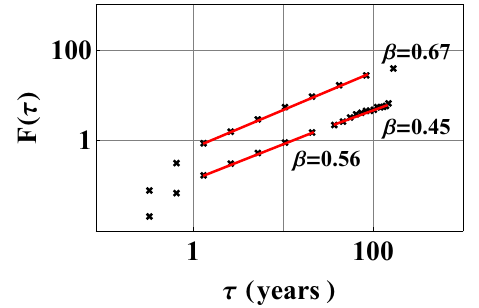
Figure 14. DFA2 applied to sea surface or air surface temperature at Reykjanes Ridge. The upper curve is the result for the air surface temperature from Erik1 experiment. The lower left curve is based on the monthly reconstructed data for sea surface temperature, and the lower right curve on the marine sediment reconstruction of ocean temperature. The red lines indicate the scales used to estimate β